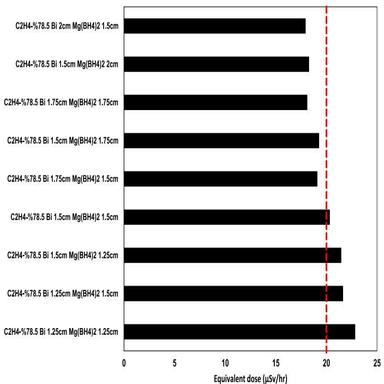
Total Equivalent dose values for different combination of.Polyethylene − 78.5% Bi and Mg(BH4)2.